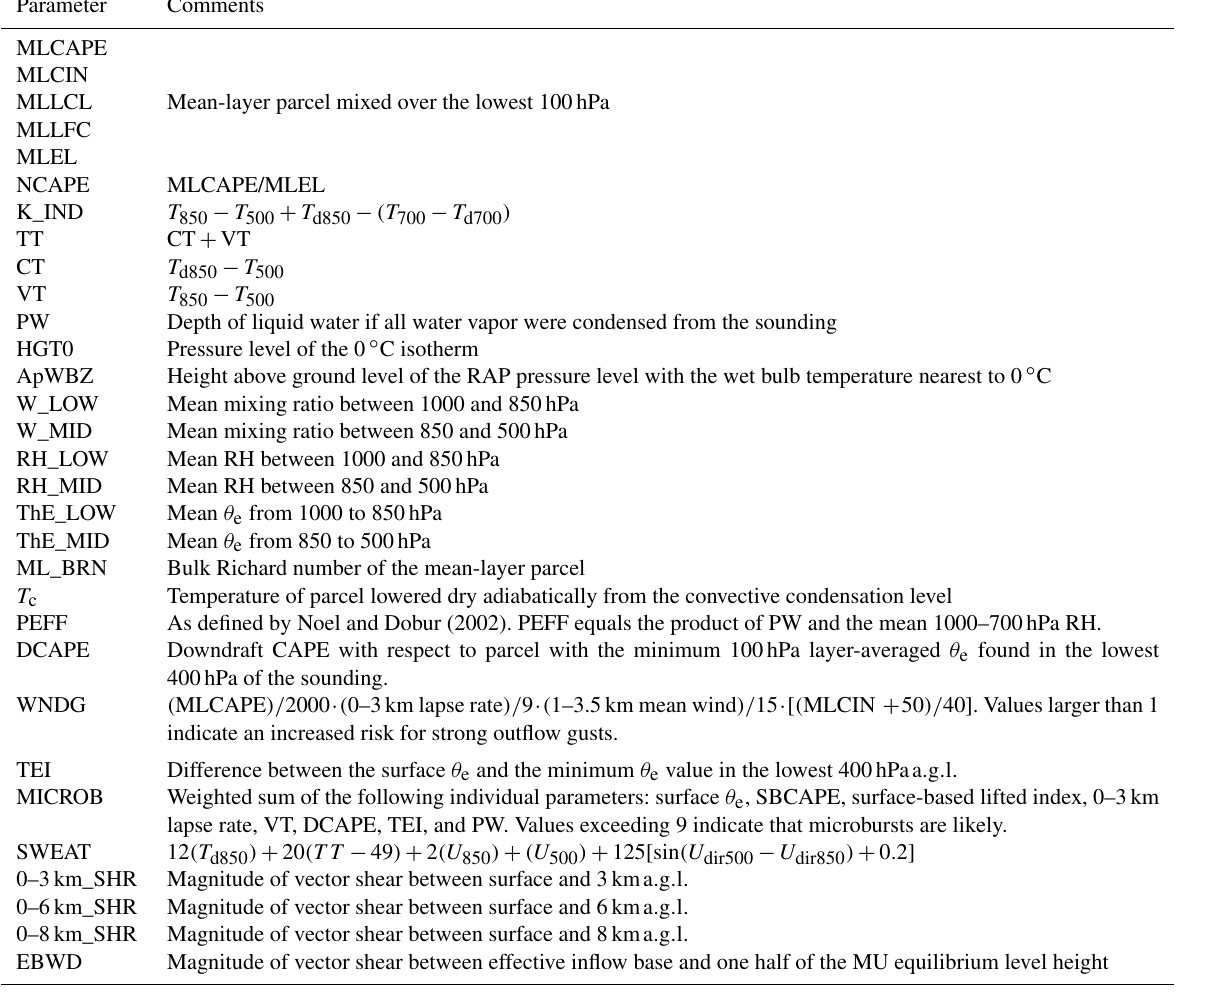
Table A1. Additional detail describing the convective parameters in Table